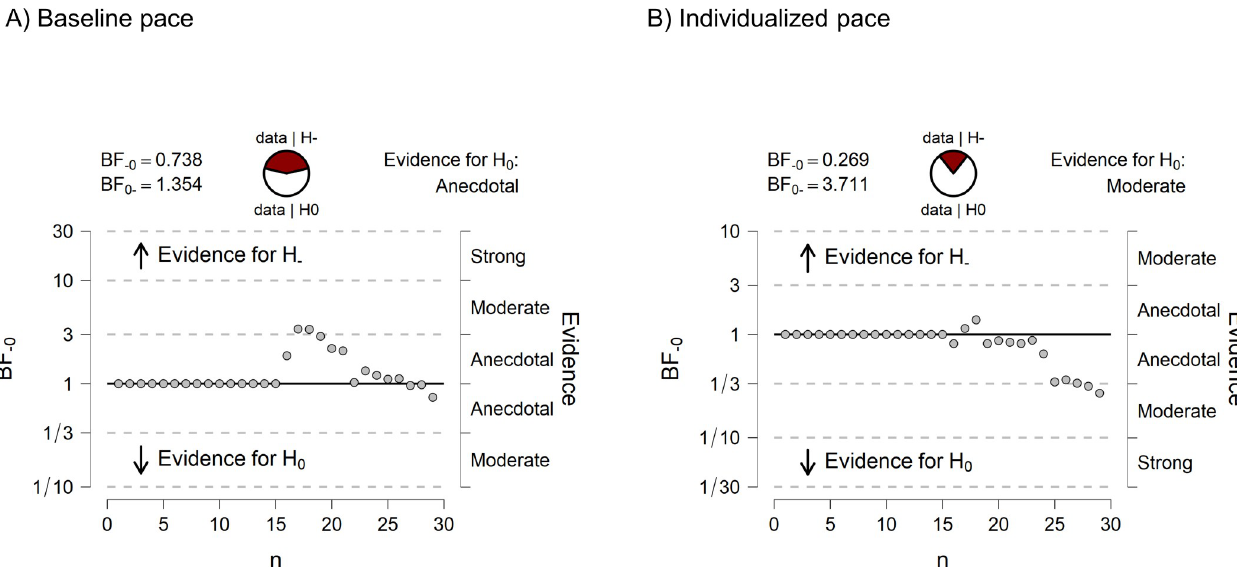
Fig 7. Sequential Bayesian analysis of the mean spans in Experiment 2. The panels reproduce the output from Jasp (Jasp Team, 2022) The x-axes in the plots represent the participant number and the y-axes represents the magnitude of the BF 10 at every new addition of a data point in the analysis. A BF 10 = 1 means that the null and the alternative hypothesis are at odds. The horizontally aligned dots until n = 14, on the left side of each plot, correspond to the BF 10 after the addition of data in the ADHD group. From n = 15 onwards, the dots represent the cumulative changes in the BF 10 after the addition of data in the control